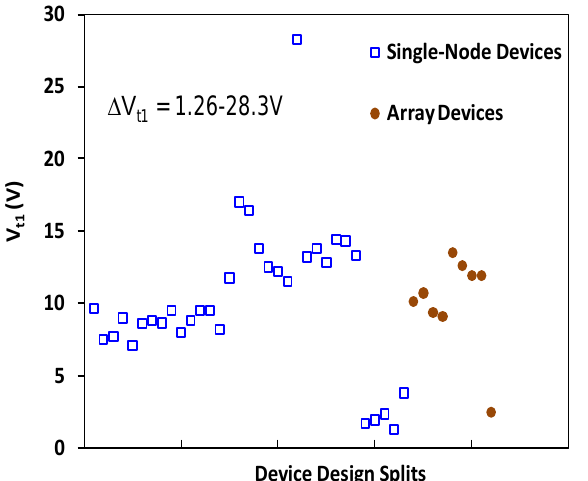
Figure 27. TLP testing of sample nano-crossbar ESD-protection structures shows dual-directional ESD discharge I-V characteristics: ( a ) single-node 5 μm × 5 μm ESD device, and ( b ) 5 × 5 nano-crossbar array ESD device [48].